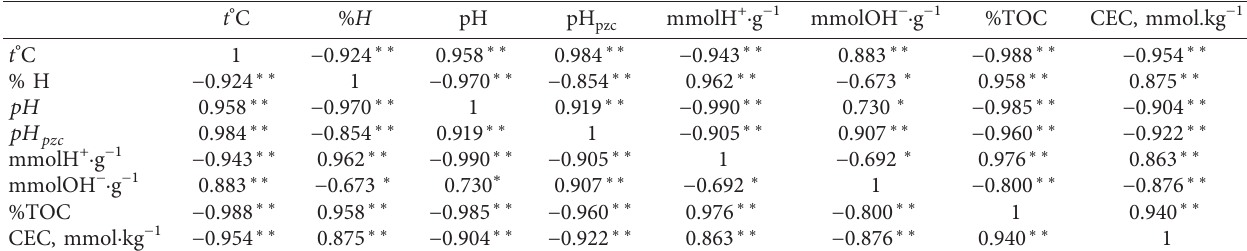
Table 2: Correlations between physical chemistry properties of biochar.